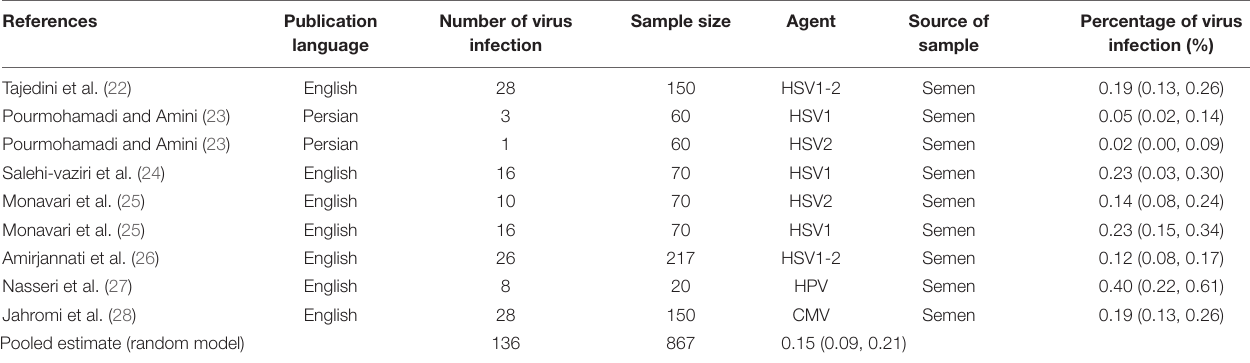
TABLE 2 | Cross-sectional virus studies included in the meta-analysis.